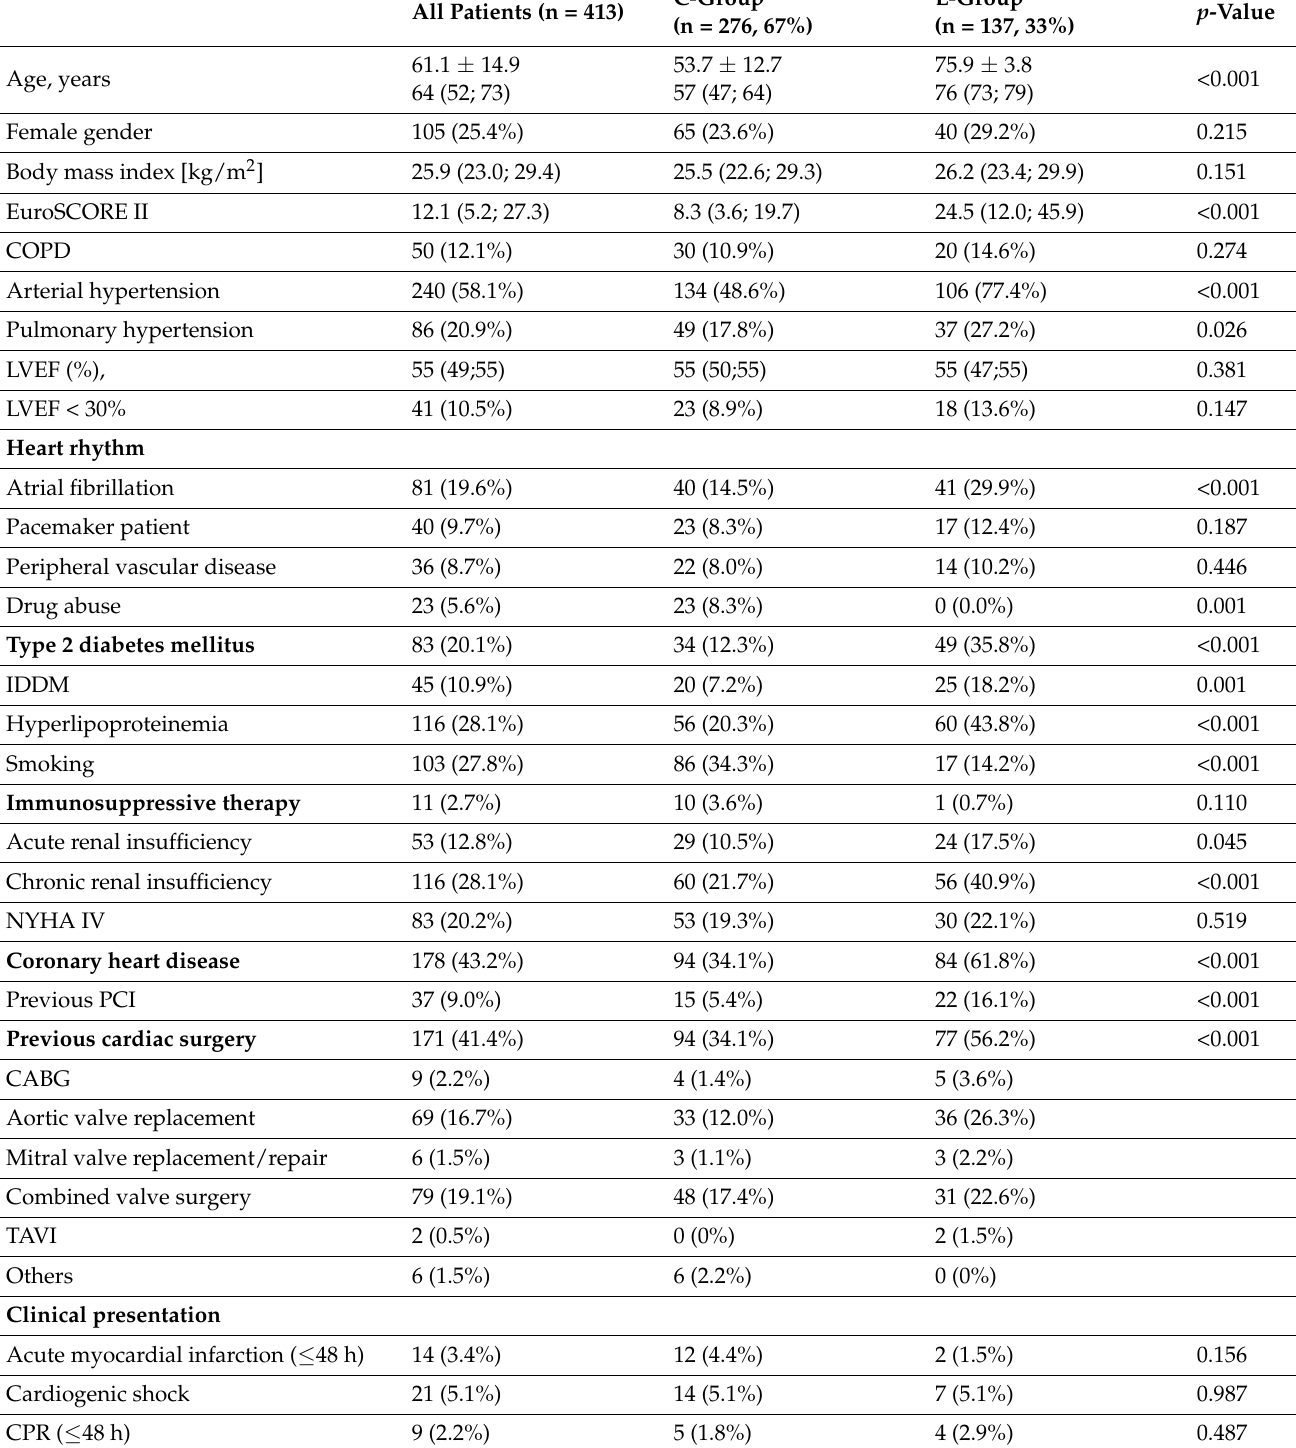
Table 2. Patients’ baseline